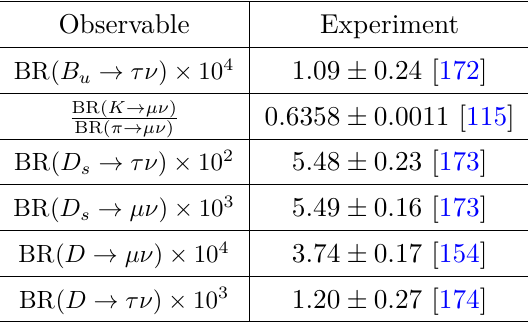
Table 3 . Additional leptonic decays of mesons considered in this